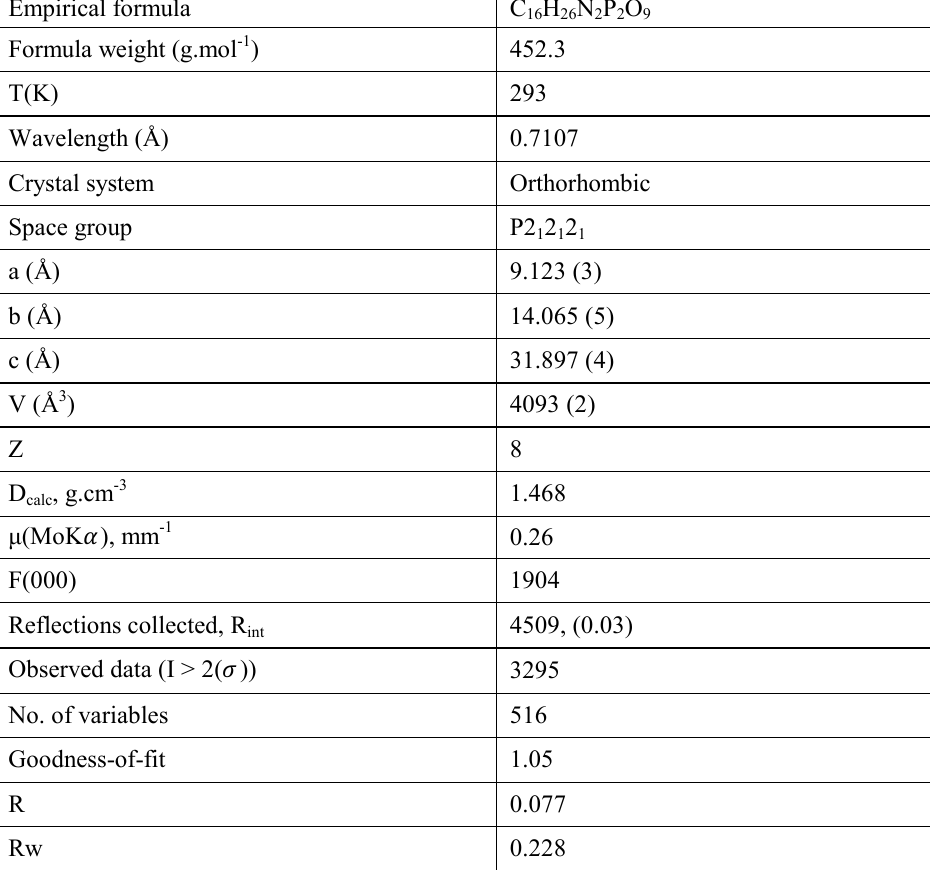
OC H CH NH ] H P O 3 6 4 2 3 2 2 2 7